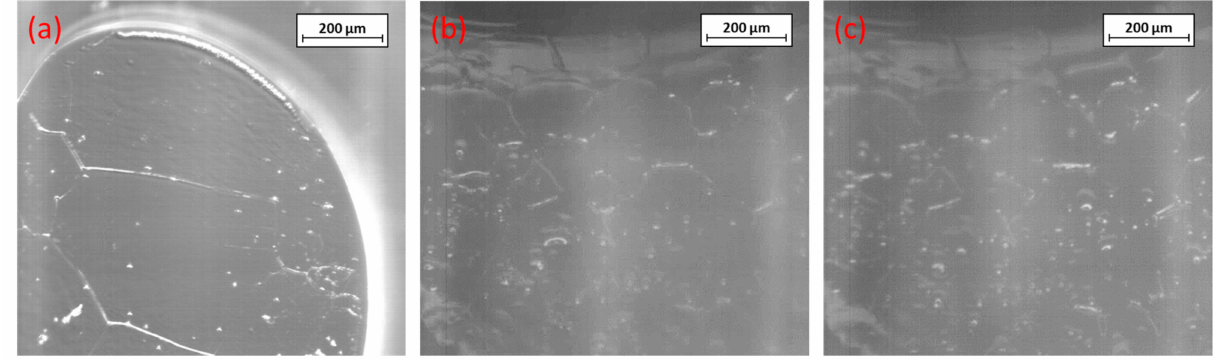
Figure 5. ( a ) Melting of the plate at the grain boundaries and steel/slag/gas interface; ( b , c ) melting below the slag surface.